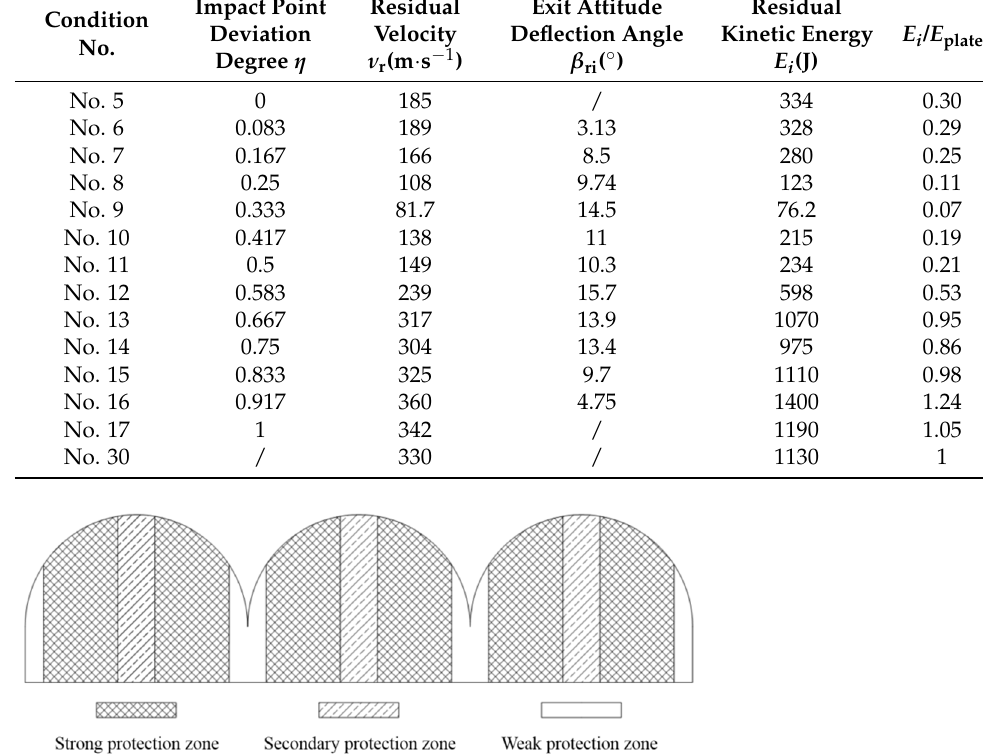
Table 5. Residual characteristics of projectile at different impact points.